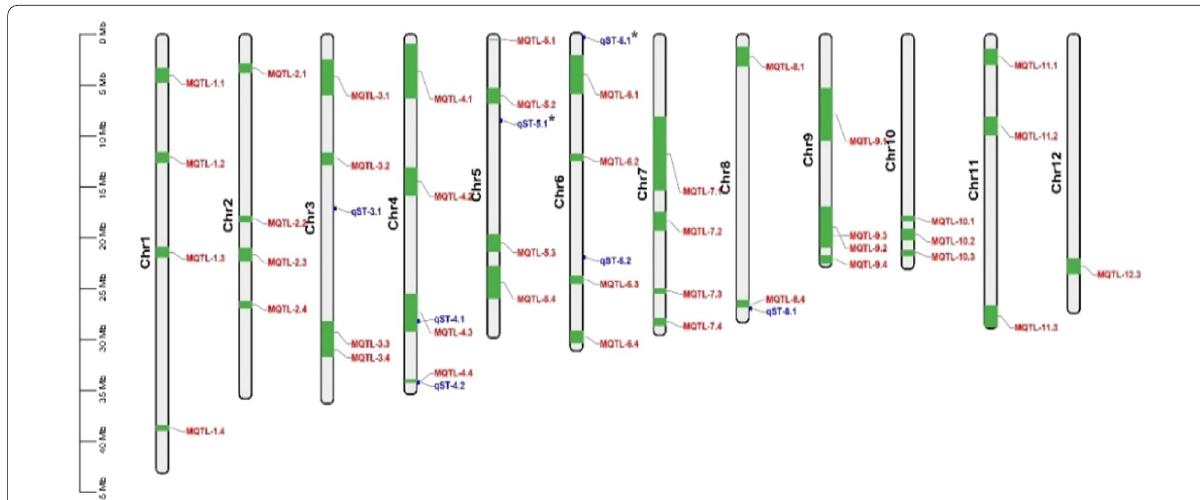
Fig. 3 The positions of our QTLs and Meta-QTLs. Red and blue QTL represents Meta-QTLs and our QTLs. Note The green and blue boxes represent the Meta-QTLs and our QTLs intervals,